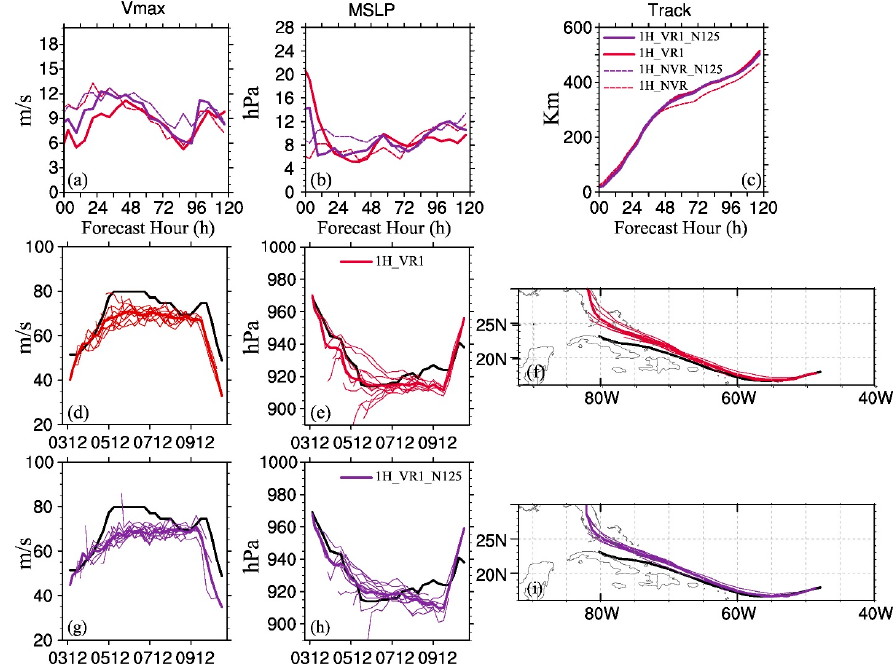
Figure 8. Same as Figure 2, except for “1H_VR1” (solid red), “1H_VR1_N125” (solid purple), “1H_NVR” (dashed red), and “1H_NVR_N125” (dashed purple).